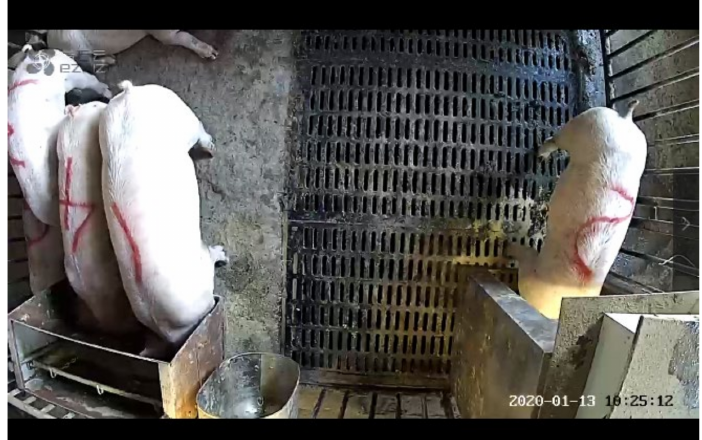
Figure 3. Pen and the layout of